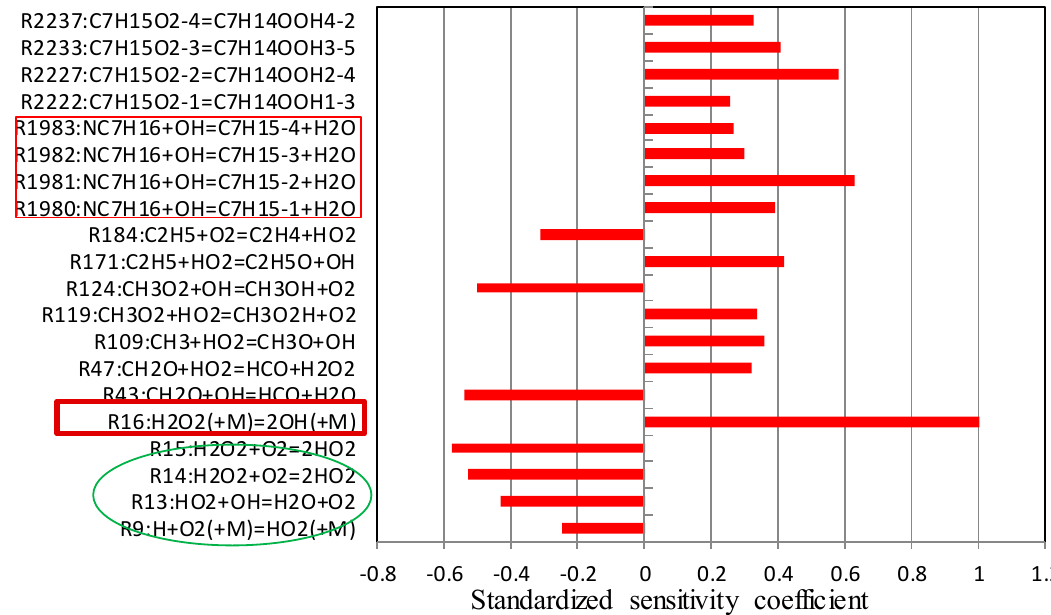
Figure 11. OH sensitivity analysis of N-heptane in the condition of 725